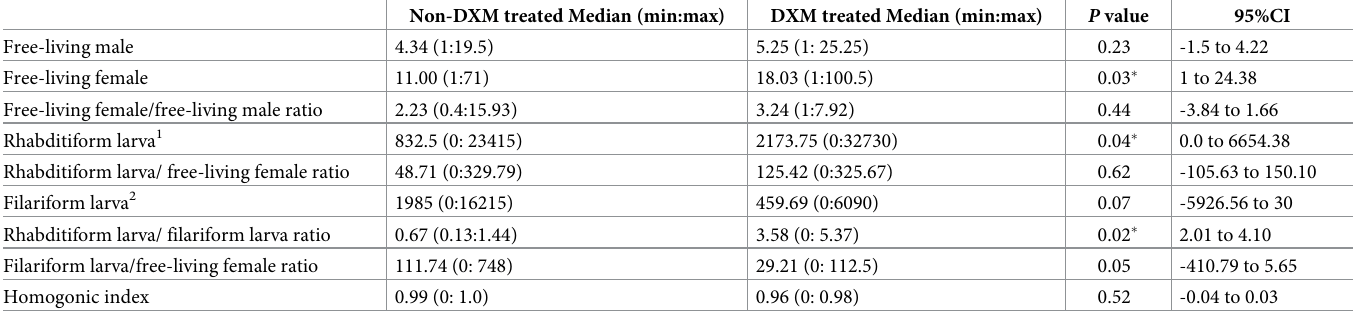
Table 1. Median numbers of indirect development of human S . stercoralis from agar plate cultures maintained for 72 hours in the presence or absence of dexameth- asone (DXM). Non-DXM treated Median (min:max) DXM treated Median (min:max) P